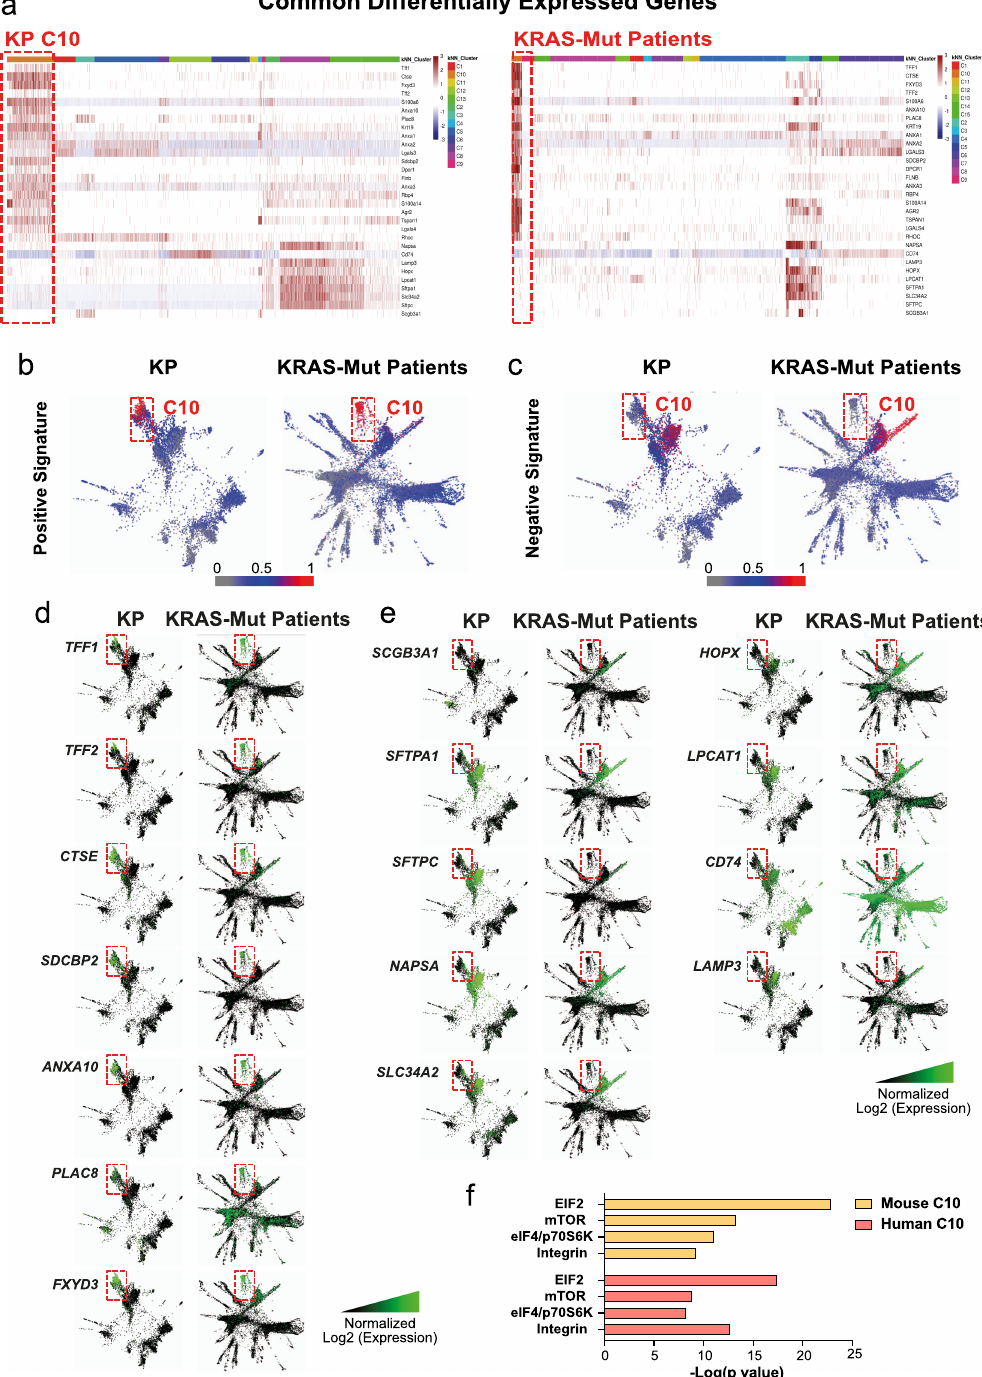
Fig. 4 Human and murine KP ADCs display a tumor cluster speci fi cally associated with harboring KRAS mutations. a Heatmap of the common differentially expressed genes in both murine (upper panel) and human (lower panel) KRAS- mutated ADCs, as de fi ned by differential gene expression analysis. Row-scaled z scores of the log2-normalized expression values per gene are shown. b – c SPRING plots showing the common signature enrichment score for C10 clusters, calculated for each cell equivalent to the number of detected genes from the common signature shown in a . For the positive/ upregulated (4 b ) and the negative/downregulated signature (4 c ) the more genes detected per cell, the stronger the enrichment score, represented as a scale from 0 (gray) to 0.5 (blue) to 1 (red), where an enrichment score of 1 signi fi es detected expression of all marker genes within that cell. SPRING plots showing a visual representation of the log2-normalized gene expression for the selected d , upregulated, and e downregulated genes of interest in both murine (left panels) and human (right panels) C10 clusters. f IPA analysis showing common top three enriched pathways in KP and Human